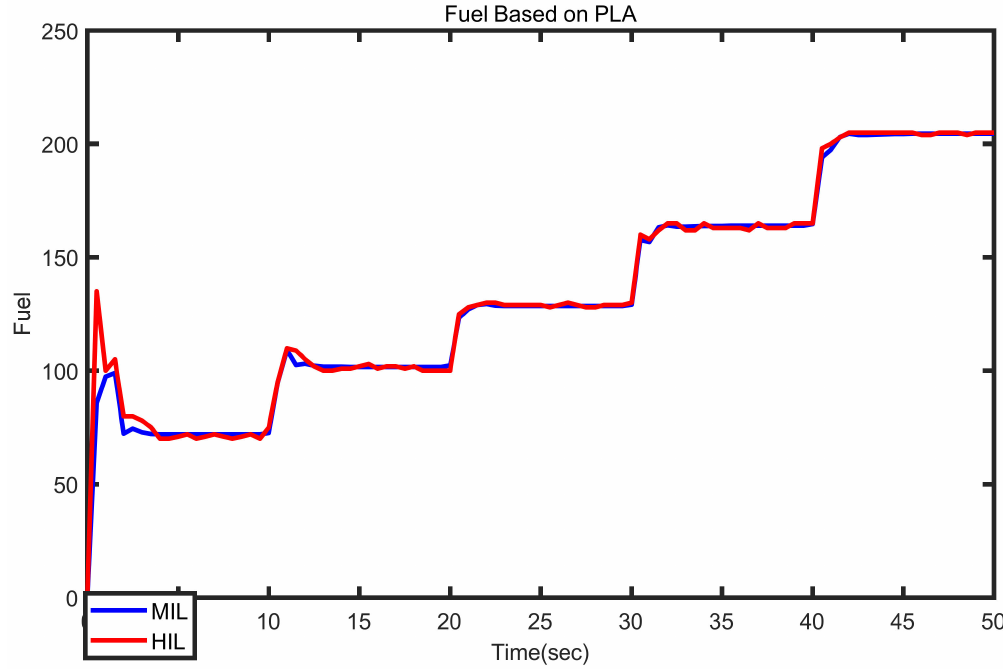
Figure 19. MIL and HIL Fuel signal comparison for